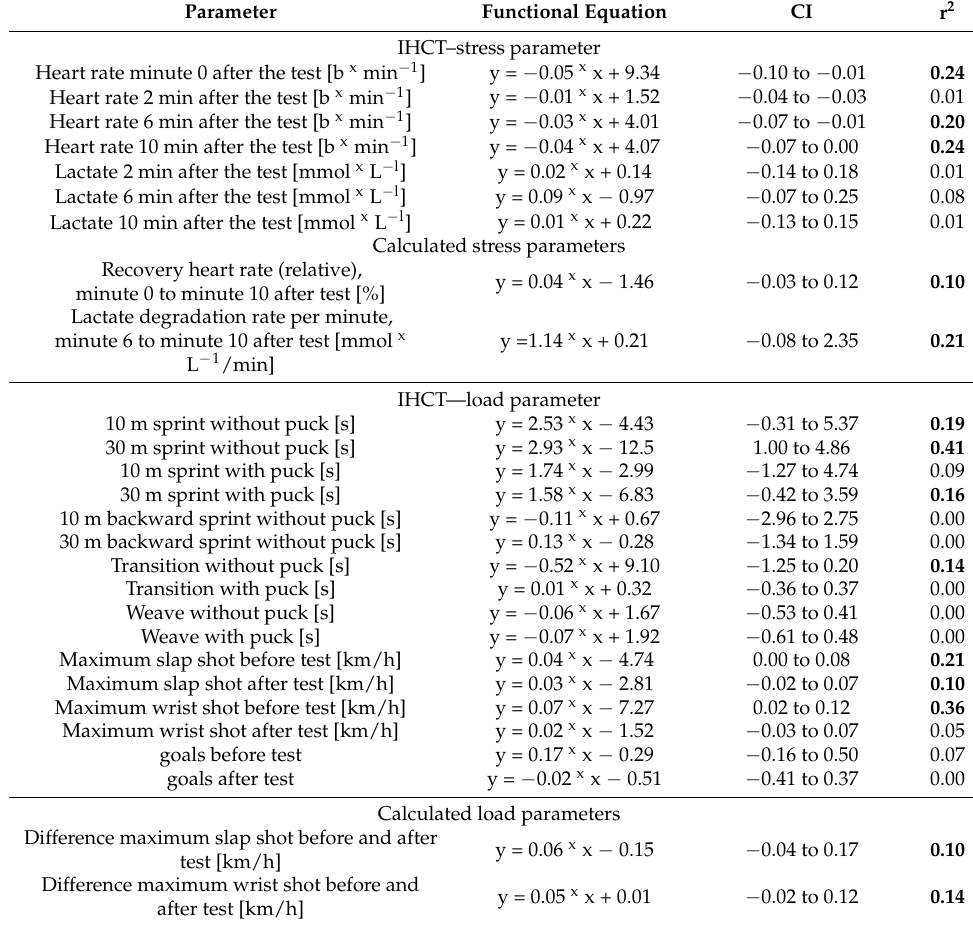
Table 3. Comparison of the IHCT parameters with the match performance score (MPS) as gold standard by means of linear regression analysis (model: inclusion). CI = confidence interval. r 2 ≥ 0.10 marked in